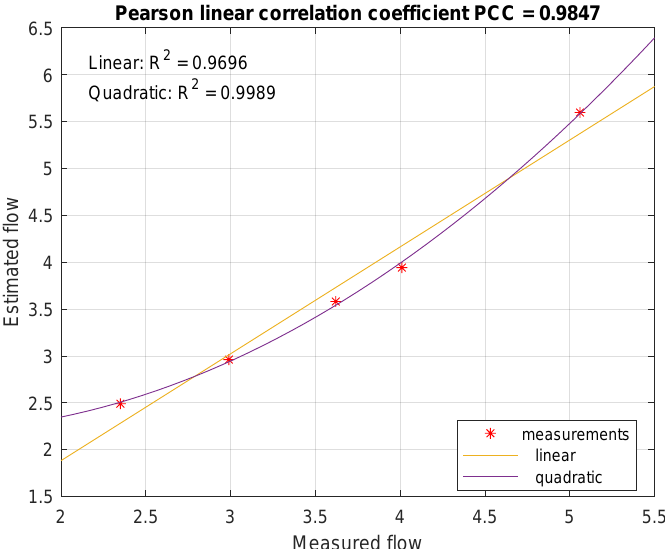
Figure 7. The relationships between the uncalibrated estimates achieved using the proposed simpli- fied approach utilizing the Lucas–Kanade method and the velocities measured using the water-flow meter in the presence of